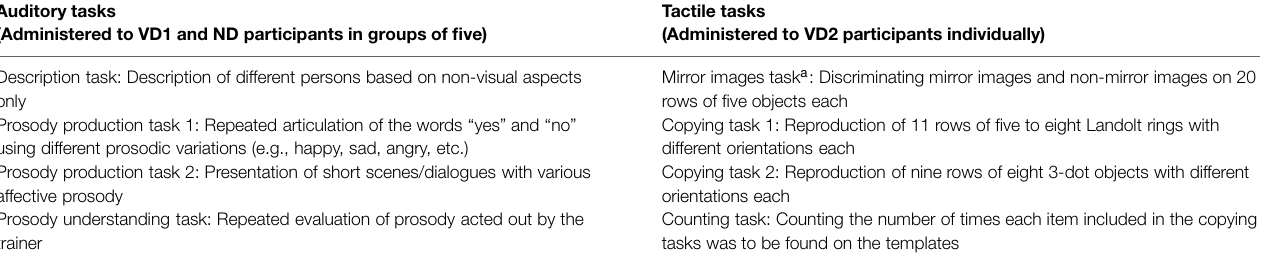
Frontiers in Integrative Neuroscience |